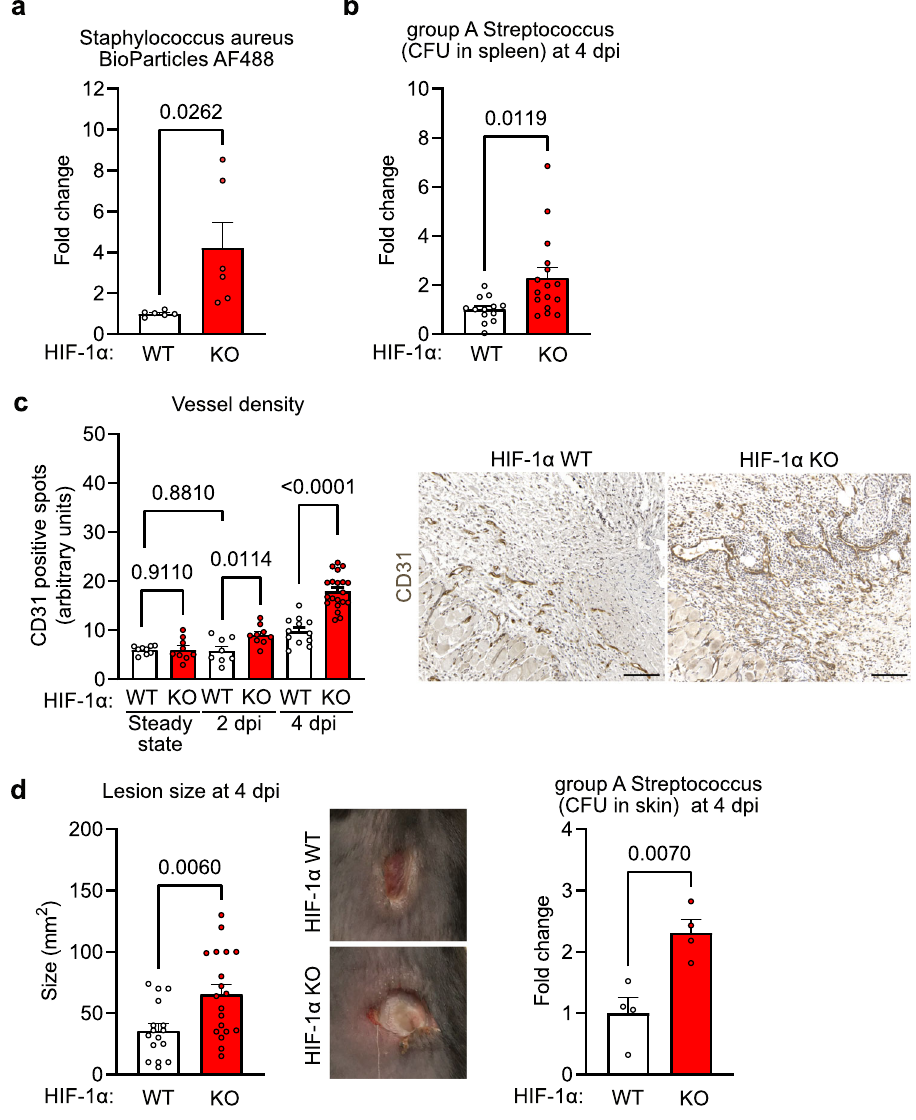
Fig. 4 HIF-1 α in NK cells is required to control bacterial skin infections. a Flow cytometry analysis of the spleen from WT and HIF-1 α KO animals for Staphylococcus aureus bioparticles labelled with AlexaFluor 488 injected to the injury site, pooled of 3 experiments, two-tailed Student ’ s t test. b Colony forming units (CFU) of group A Streptococcus (GAS) in the spleen from WT and HIF-1 α KO animals at 4 days post infection (dpi), pooled data of 4 experiments, ( n = 13 for WT and n = 16 for HIF-1 α KO), two-tailed Student ’ s t test. c Left, quantitative analysis of CD31-positive endothelial cells in skin lesions at 2- and 4- dpi with GAS from WT (steady state, n = 9; day 2, n = 8; day 4, n = 12) and HIF-1 α KO animals (steady state, n = 9; day 2, n = 9; day 4, n = 20), pooled data of 3 experiments, one-way ANOVA test. Right, representative images of CD31 immunohistochemistry on skin wounds. Scale bar, 100 μ m. d Left, quanti fi cation of skin lesion size at 4 dpi with GAS in WT and HIF-1 α KO animals. Pooled data of 4 different experiments, ( n = 16 lesions for WT and n = 19 for HIF-1 α KO), two-tailed Student ’ s t test. Middle, macroscopic images of GAS skin lesions in WT and HIF-1 α KO animals at 4 dpi. Right, GAS CFU in skin lesions from WT and HIF-1 α KO animals at 4 dpi, ( n = 4), two-tailed Student ’ s t test. Data are mean values ±